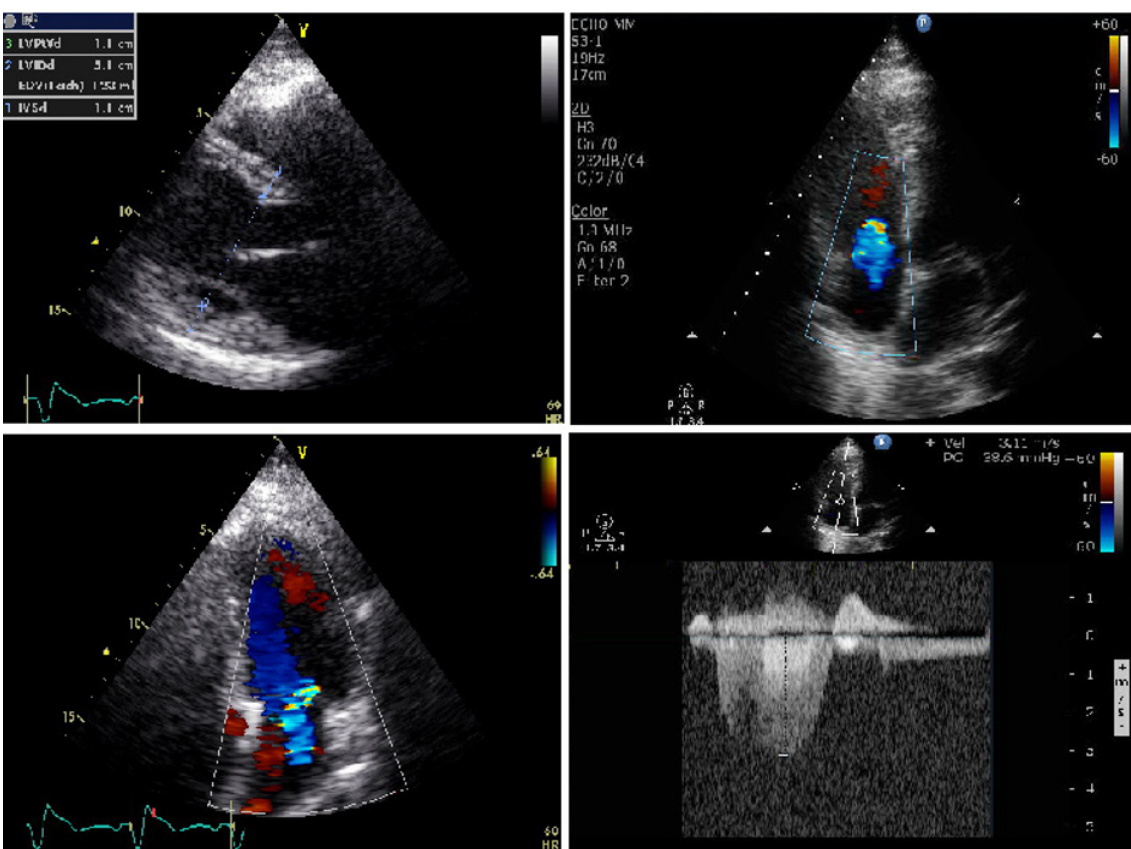
Figure 4. Echocardiography demonstrating preserved left ventricle systolic function with mild hypertrophy, mild mitral regurgitation, mild to moderate tricuspid regurgitation, and mild to moderate pulmonary hypertension.